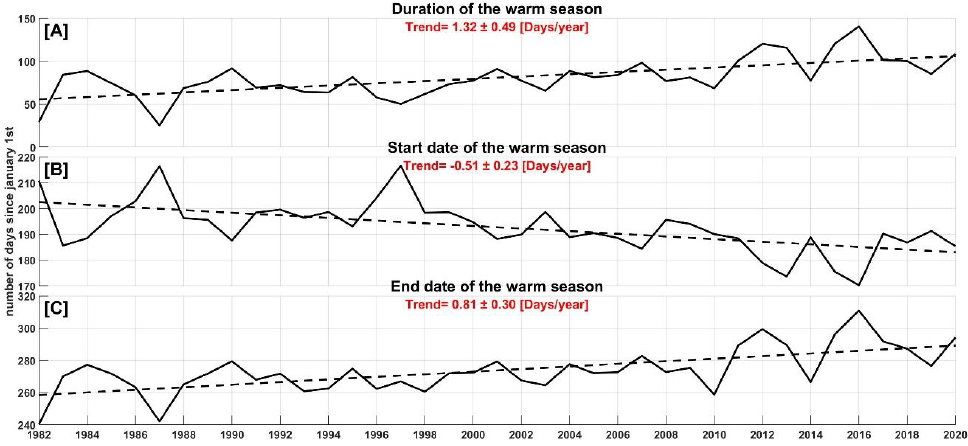
Figure 5. Changes in SST phenology over the entire Barents Sea for the 39 years (1982 – 2020), demonstrating the trend of ( A ) the duration of the warm season, and the start ( B ) and the end ( C ) date of the warm season.